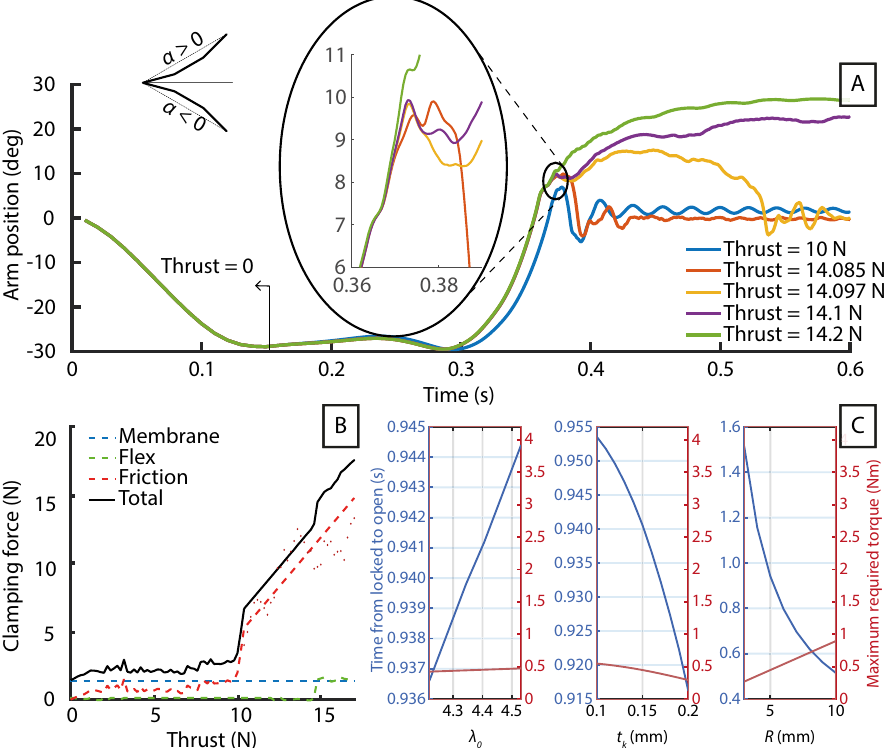
Figure 4. Simulation data. ( A ) Dynamic finite element simulation of the effect of thrust on the morphing arm’s locking behavior and ( B ) the clamping force holding the arm in the locked state. ( C ) Parametric studies of how the arm geometries affect the locked-to-unlocked transition time and servomotor torque requirement using numerical